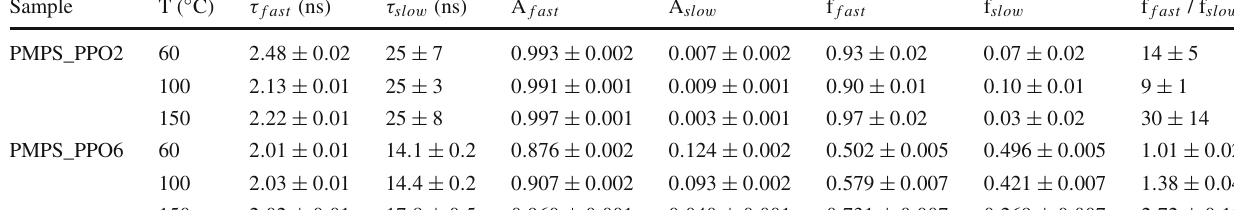
Table 2 Parameters obtained from the interpolation of the decay profiles in Fig. 5 Sample